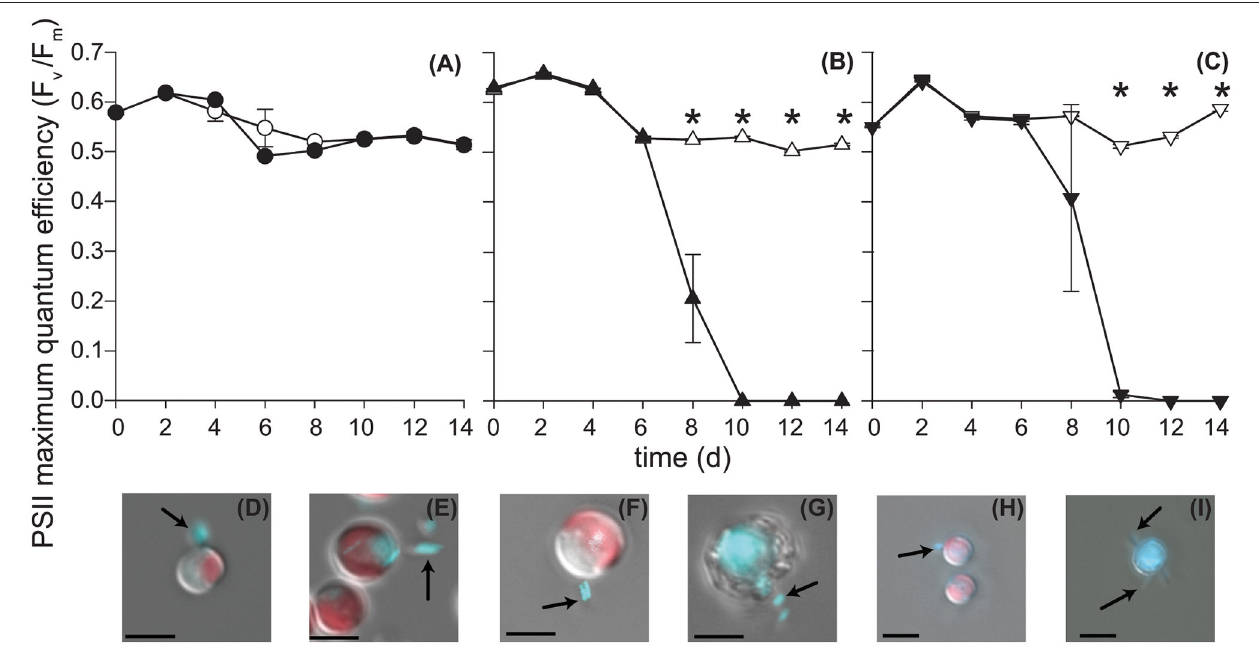
FIGURE 2 | P. inhibens effect on E. huxleyi’s photosynthetic health. P. inhibens was co-cultured with non-calcifying diploid N cells (CCMP2090), diploid calcifying C cells (CCMP3266), and haploid S cells (CCMP3268) E. huxleyi . The maximum quantum efficiency (F v /F m ) is shown for (A) CCMP2090 (circles), (B) CCMP3266 (triangles) and (C) CCMP3268 (upside down triangles). Data for axenic algal cultures are filled in white, whereas data from co-cultured experiments are solid black. Triplicate wells that represent independent experiments were sacrificially sampled at each time point; error bars represent ± 1 standard error. An asterisk (*) at a time point indicates that it is significantly different to the control. Statistical significance was determined using a one-way ANOVA and Tukey HSD test. Differential interference contrast images of (D) CCMP2090 co-culture with P. inhibens healthy, day 6 and (E) healthy, day 10, (F) CCMP3266 co-culture with P. inhibens healthy, day 6 and (G) dying, day 10, (H) CCMP3268 co-culture with P. inhibens healthy, day 6 and (I) dying, day 10 . Images are shown overlaid with two fluorescent channels: chlorophyll auto-fluorescence (red: excitation 610–650nm; emission 670–720nm) and DNA–DAPI complex fluorescence (blue: excitation 350–400nm; emission 417–477nm). DAPI-stained P. inhibens cells attached to algal host and non-associated are indicated by black arrows. The scale bar represents 5 µ